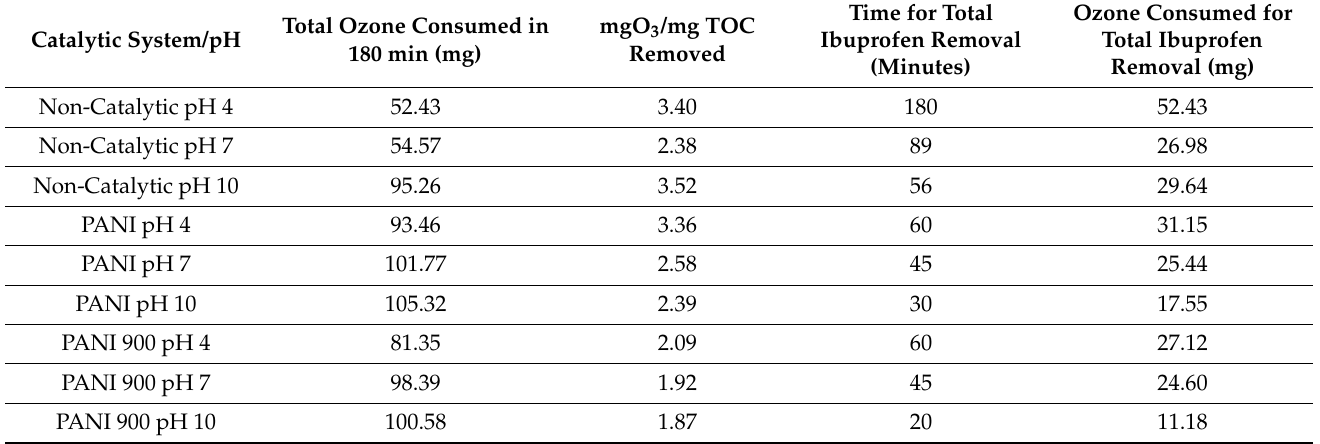
Table 3. Ozone consumption during the oxidation process for prepared thin films in different con- ditions.